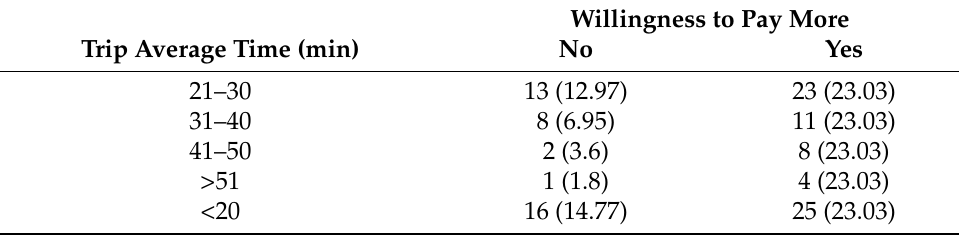
Table 5. Observed and expected willingness to pay more based on trip duration.